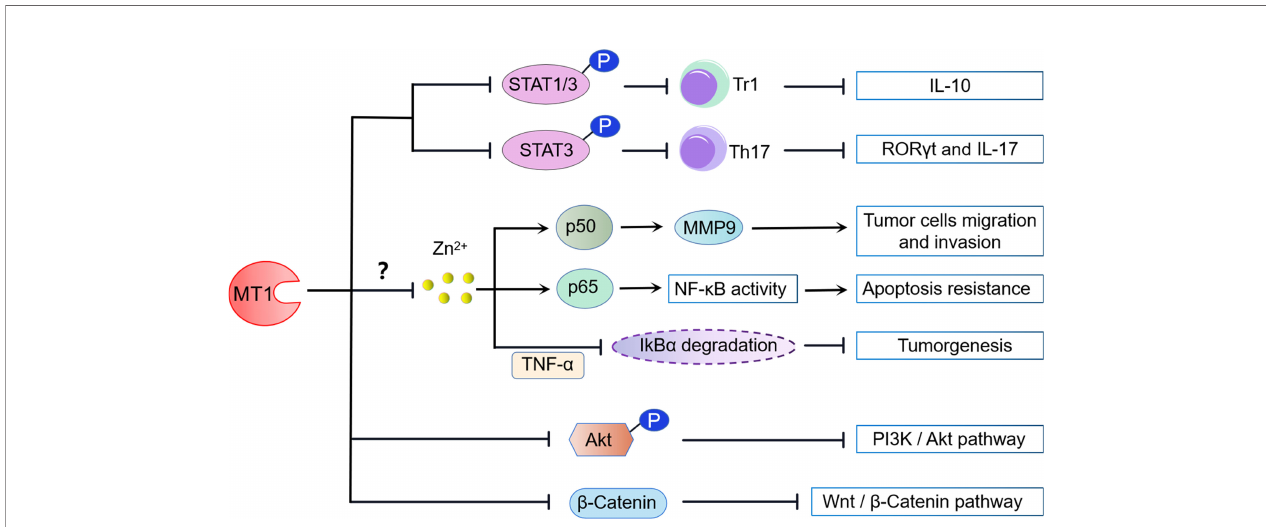
FIGURE 2 | MT1 modulated signaling pathways. (1) MT1 impairs the phosphorylation of STAT1/3, preventing the differentiation of IL-10-producing Tr1 cells. MT1 also negatively regulates Th17 cells by inhibiting the phosphorylation of STAT3. (2) MT1 can positively modulate the NF-kB signaling pathway by the upregulation of NF-kB p50/P65 activity, contributing to tumor cell migration, invasion, and apoptosis resistance. In contrast, MT1 can also dampen tumorigenesis by negatively regulating TNF- a -induced degradation of IkB a . These biological activities may be aided by MT1-mediated free Zn 2+ inhibition. (3) MT1 suppresses the PI3K/Akt signaling pathway by restraining Akt phosphorylation. (4) MT1 negatively modulates the Wnt/ b -catenin pathway by limiting the nuclear translocation of b